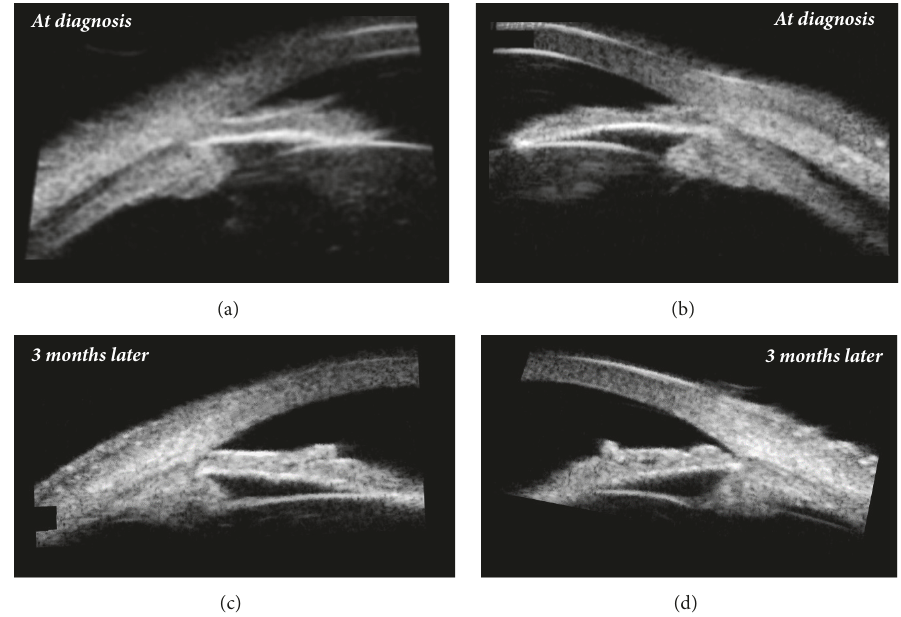
Figure 1: Ultrasound biomicroscopy showing, at diagnosis, supraciliary effusion, anterior rotation of the ciliary body and iridocorneal angle narrowing ((a) right eye; (b) left eye) and, three months later, resolution of the effusion and widening of the iridocorneal angle ((c) right eye; (d) left